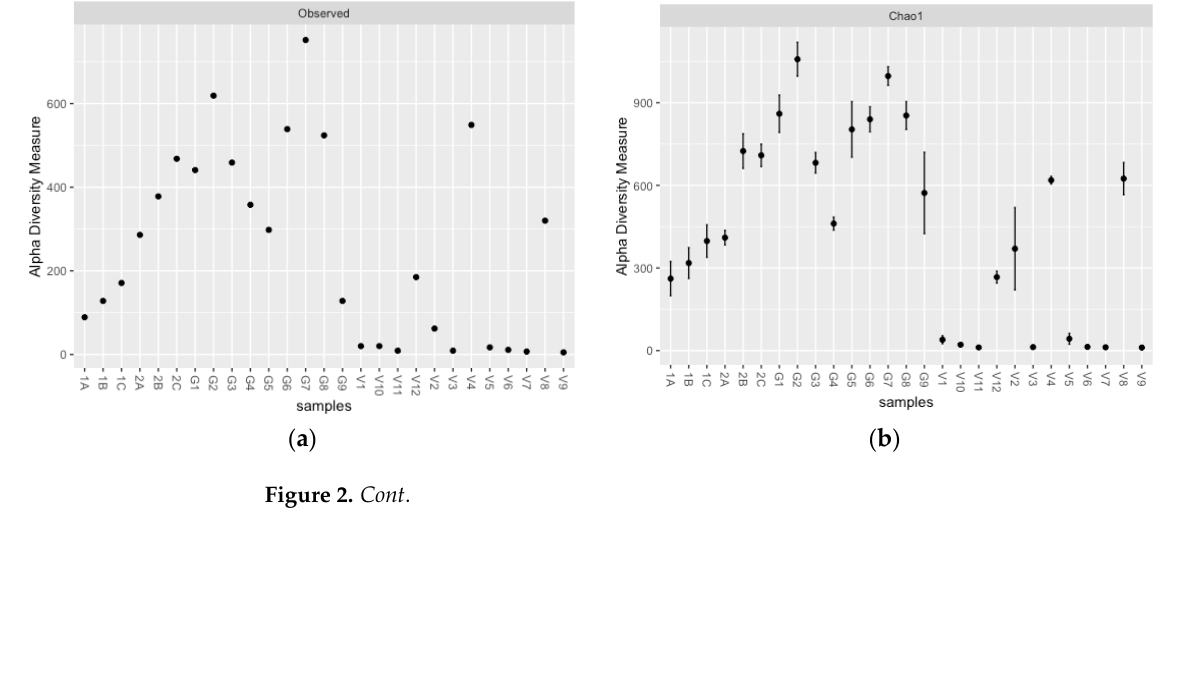
The observed species richness and the predicted species richness (Figure 2a,b) indi- cated a higher overall species richness for GK compared to NR and VV, with VV exhibiting the lowest species richness. Greater actinobacterial diversity (Shannon index > 4) was also observed for NR and GK compared to VV, except for the deepest VV samples (Figure 2c).